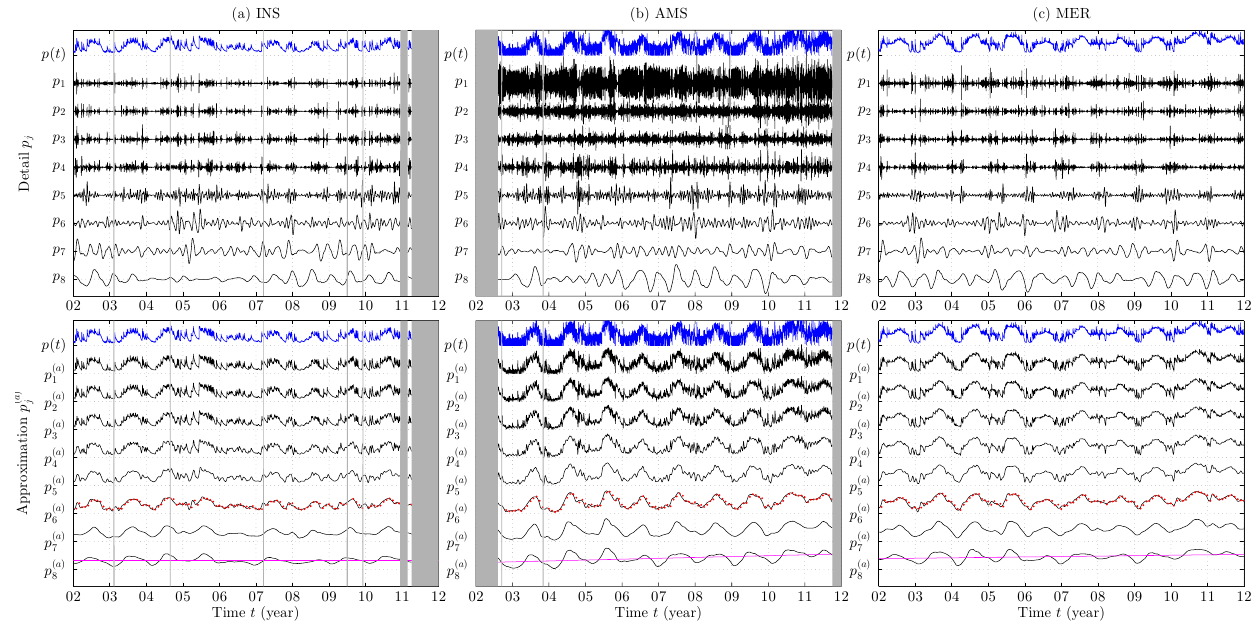
the approxi- j are monthly means of p , and magenta lines are trend 6